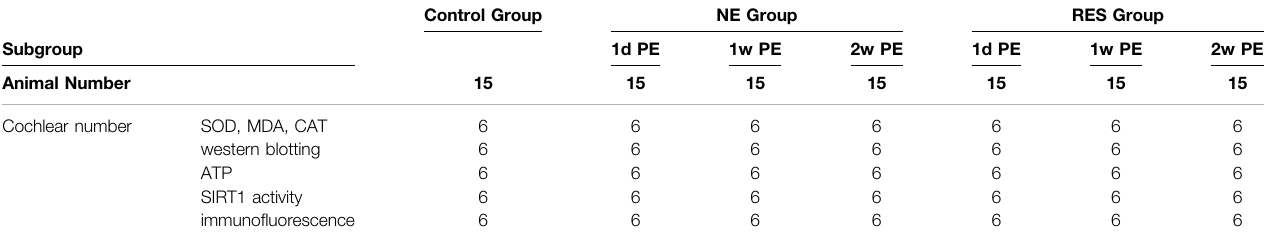
TABLE 2 | Distribution of cochlear specimens of guinea pigs in the second